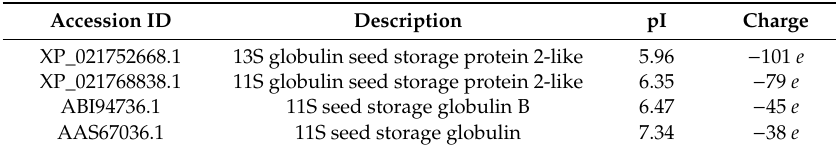
Table 2. Isoelectric point and charge calculated at pH 8.0 of the identified chenopodin isoforms; e is the charge of one electron.